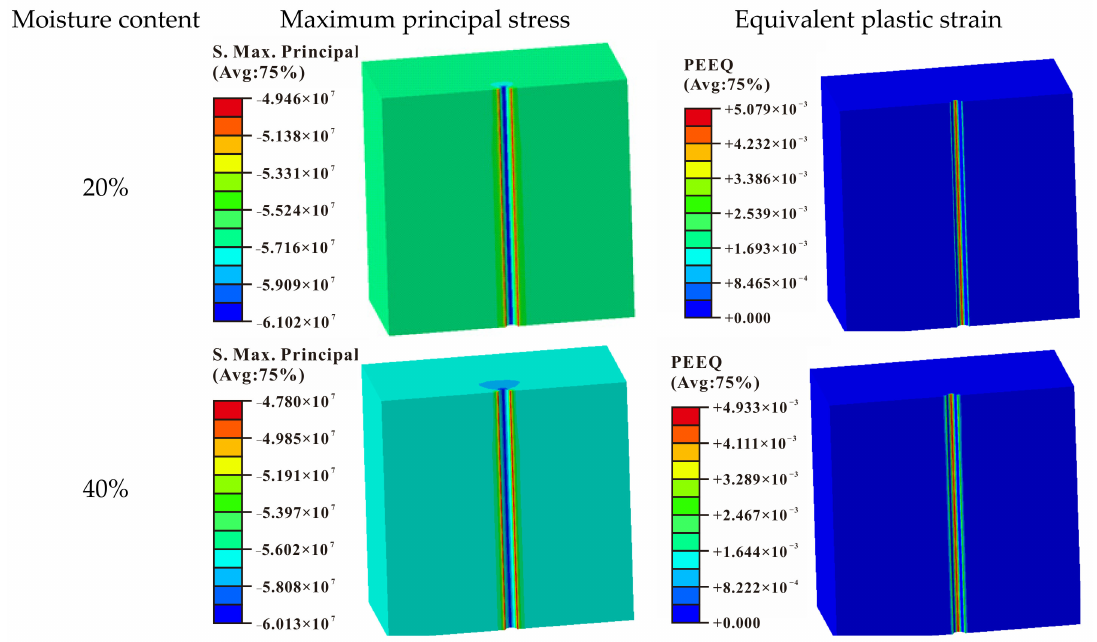
Figure 11. Maximum principal stress and the equivalent plastic strain distribution of the wells at CSL for different moisture